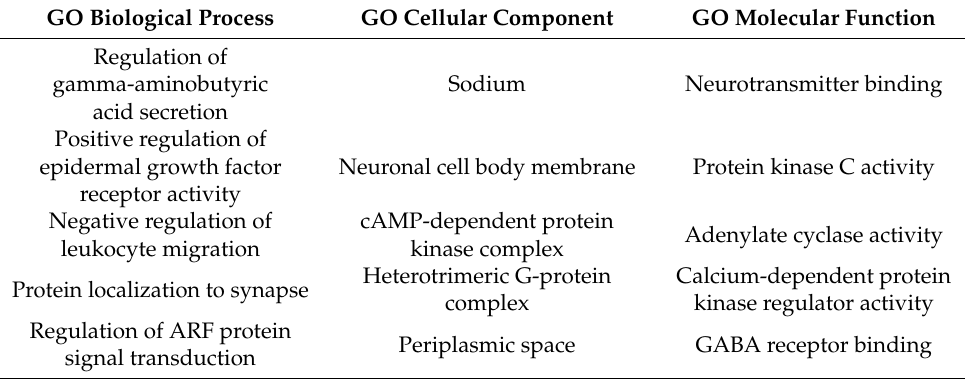
Table 7. Top 10 GO biological processes, cellular components, and molecular functions enriched from differentially expressed genes that are downregulated in MMC spinal cords compared to vehicle at E15. All GO pathways were >1.5-fold and p <